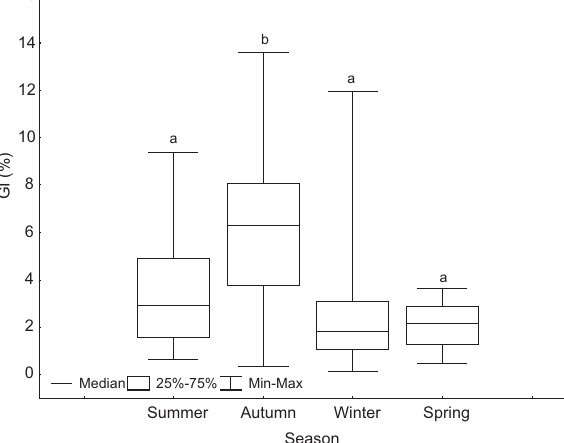
Figure 3. Seasonal variation in the gonad index (GI) of Echinaster ( Othilia ) guyanensis collected on the southeastern coast of Brazil. (n = 40 specimens per season). Letters designate statistical differ- ences (different letters) as indicated in the non-parametric Tukey test (p <